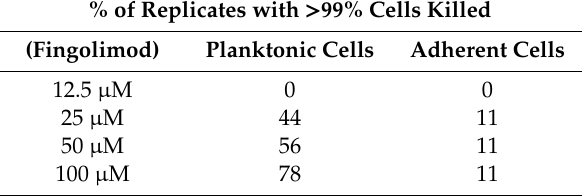
Table3. MBCandBPCconfirmationoffingolimodagainst A.baumannii NCTC13423afterapre-exposure treatment. Results are expressed as the percentage of replicates for which > 99% of cells were killed (one or less colony counted) ( n = 9, three separate assays with each three